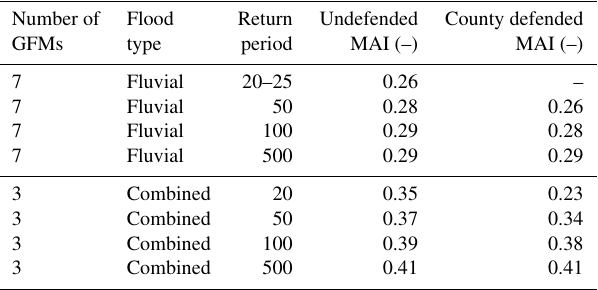
Table 5. MAI results for the undefended and county-level defended fluvial and combined hazard maps for multiple